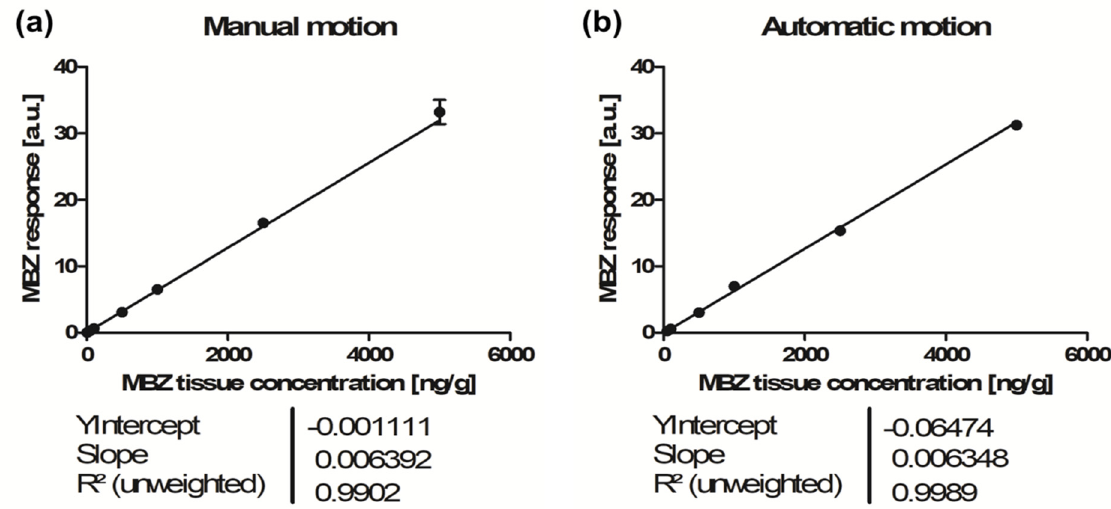
Figure 2. Calibration curves and linear regression models (1/x 2 weighting) obtained from matrix-assisted laser desorption/ionization—ion mobility—tandem mass spectrometry (MALDI-IM-MS/MS) acquisition for mebendazole (MBZ) quantification in tissue sections using 2,5-dihydroxybenzoic acid (2,5-DHB) and manual motion ( a ) or automatic motion ( b ).